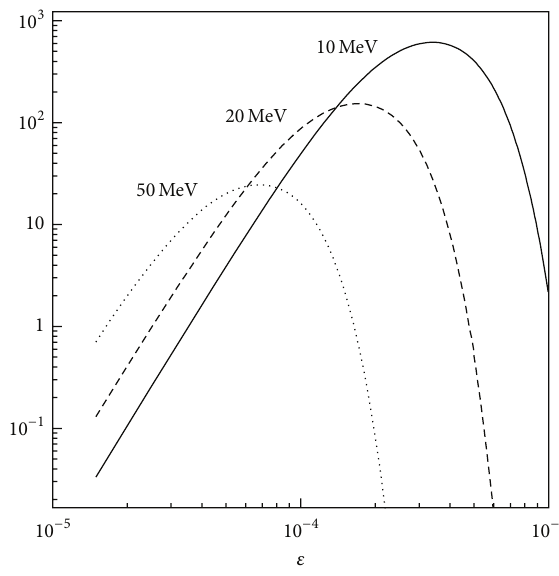
Figure 5: Number of dark photons from the process 𝐽/𝜓 → 𝜂 󸀠 𝛾 󸀠